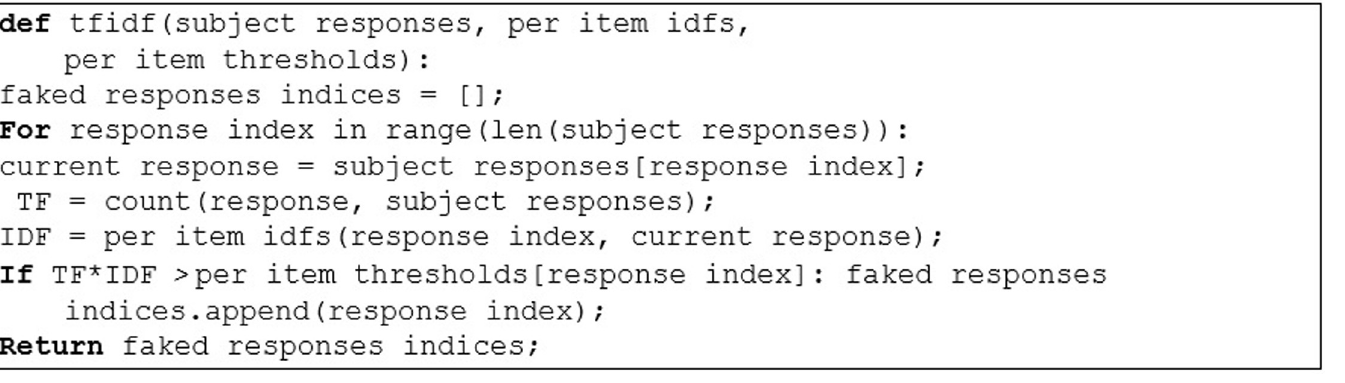
Fig 1. Code Snippet 1. TF-IDF for single-item faking-detection.